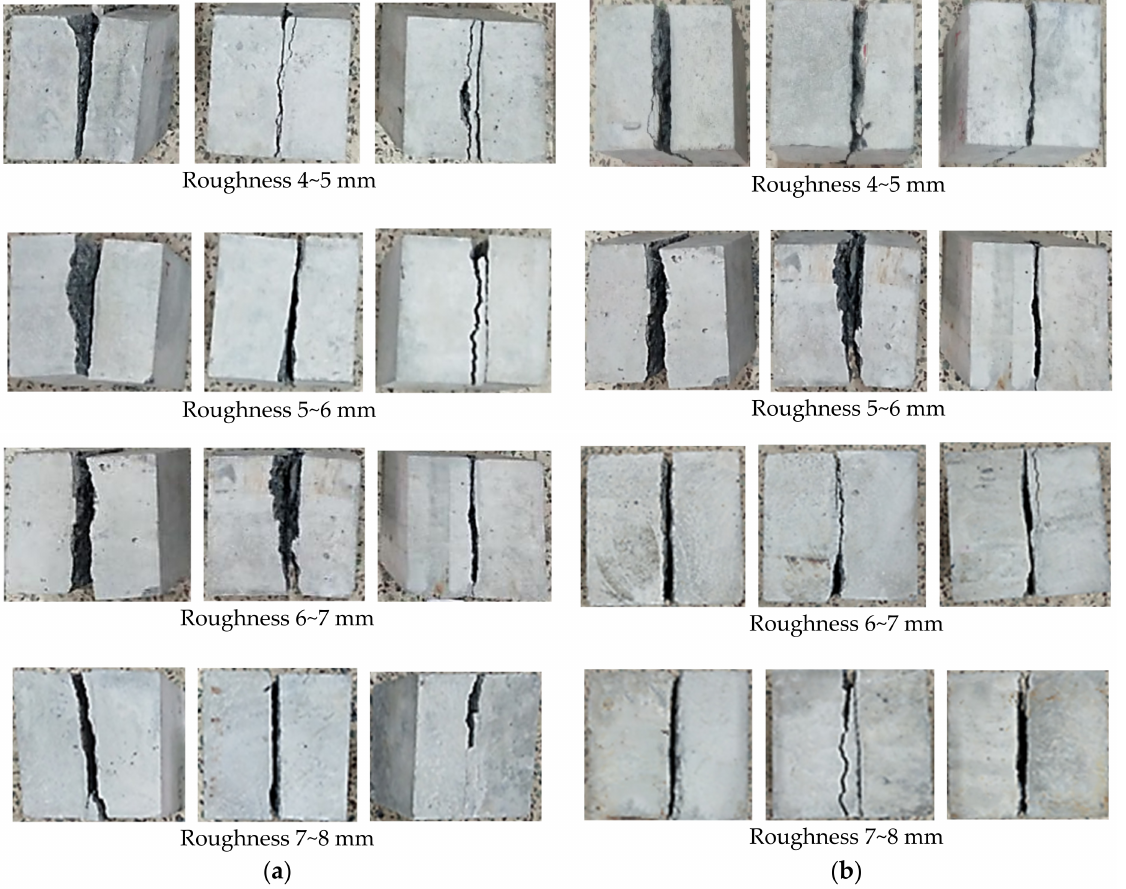
Figure 9. Failure mode of specimens with different roughness of precast concrete in dimension of 150 mm × 150 mm: ( a ) C45 cast-in-situ concrete to C40 precast concrete; ( b ) C35 cast-in-situ concrete to C30 precast